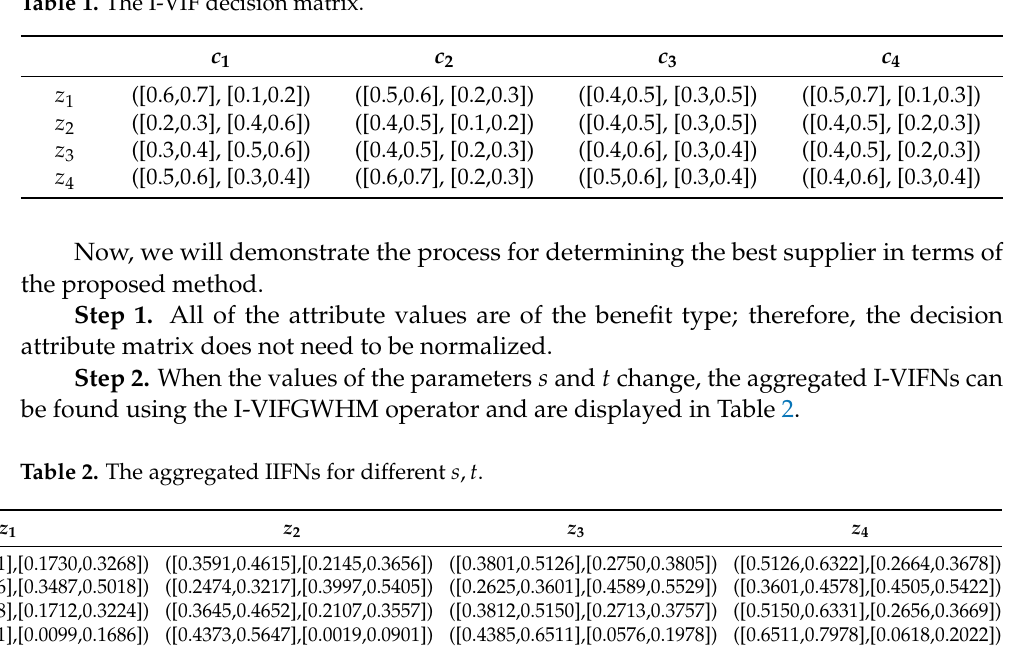
Table 3. Scheme sorting results for different s , t .